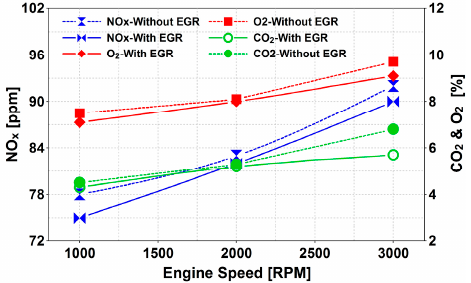
Figure 15. Influence of In/Ex-EGR on NOx, CO 2 and O 2 concentrations at idling and low/mid-load settings (rpm = 1000 – 3000, IMEP = 1 – 2.1 bar, T epc = 385 – 530 K, AFR = 14 – 16).